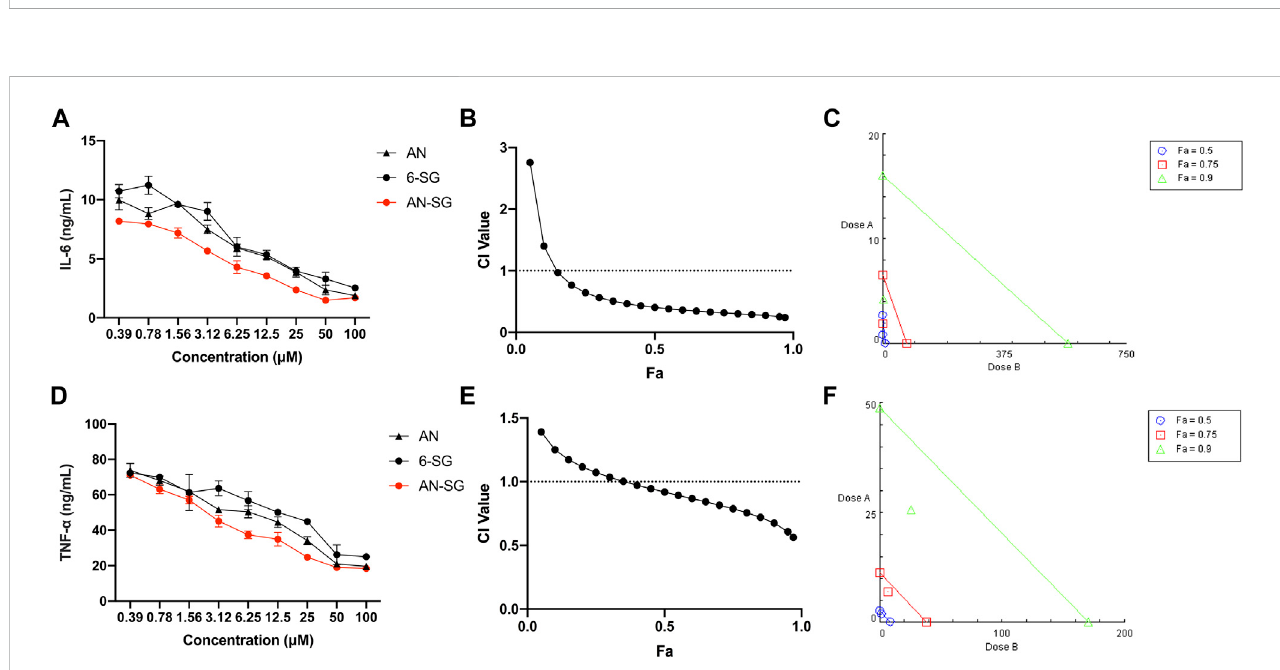
The AN-SG combination exhibited synergistic effects on inhibition of LPS-induced IL-6 and TNF- α productions in mono-cultured N11 cells. AN, 6-SG andAN-SG dose-dependentlyinhibitedLPS-inducedIL-6 (A) andTNF- α (D) inN11cells( n =3).The synergistic IL-6 (B) andTNF- α (E) inhibitory effectsofAN- SG were determined by the CI-Fa curves. CI values represent the interaction in AN-SG, with CI < 1, CI = 1 and CI > 1 referring to synergy, addition and antagonism, respectively. Fa on the X -axis is de fi ned as the fraction effect level, and herein it refers to the IL-6 and TNF- α inhibitory effect, respectively. Isobologram analysis of AN-SG in IL-6 (C) and TNF- α (F) inhibition when the default set of Fa values at 0.50, 0.75 and 0.90. Data are shown as mean ±